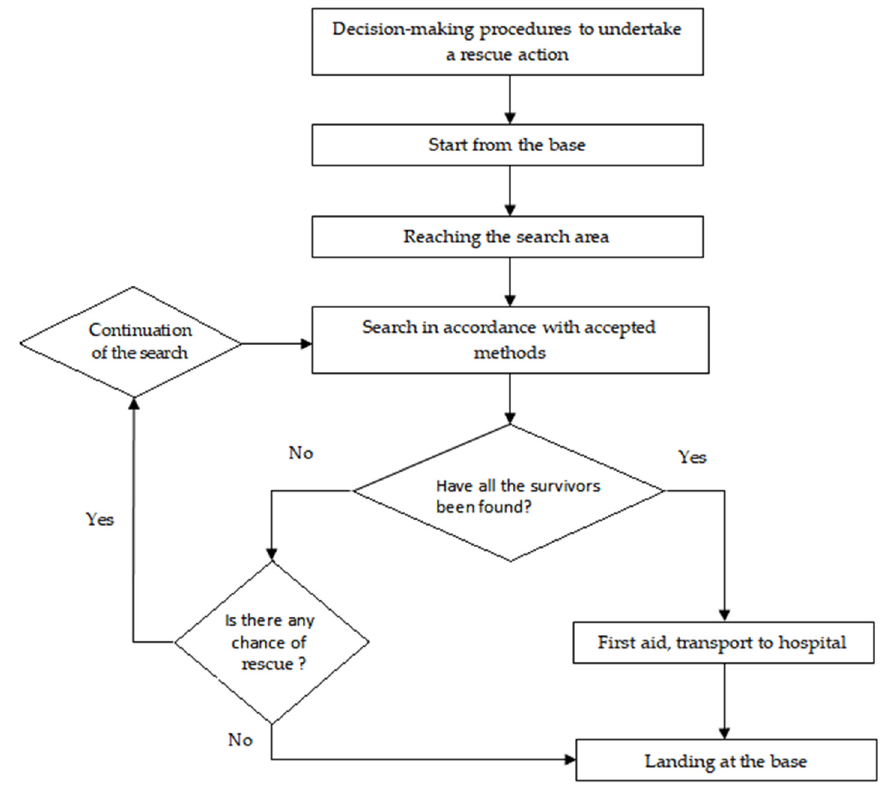
Figure 1. Algorithm for the implementation of the transport task.